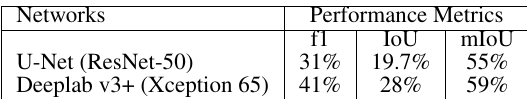
Table 3. Overall performance on 360 images.